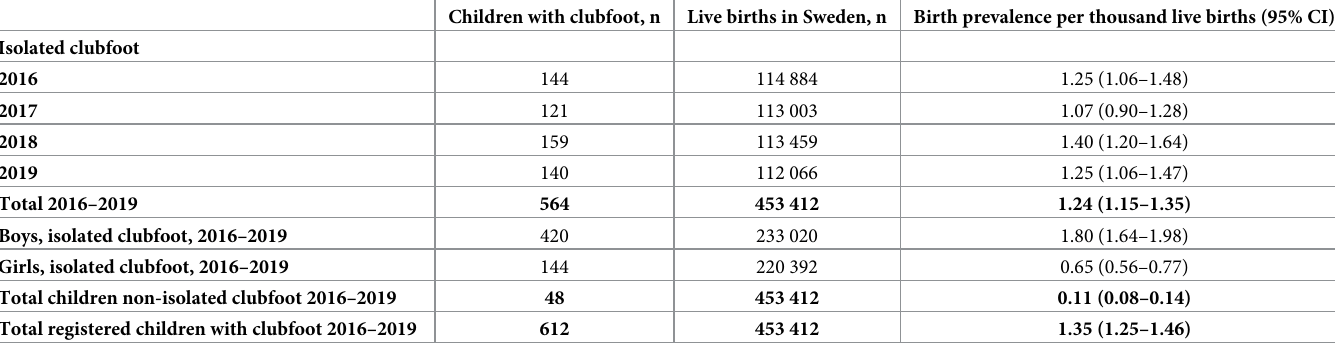
Table 1. Newborn children with clubfoot in Sweden from 2016 to 2019.